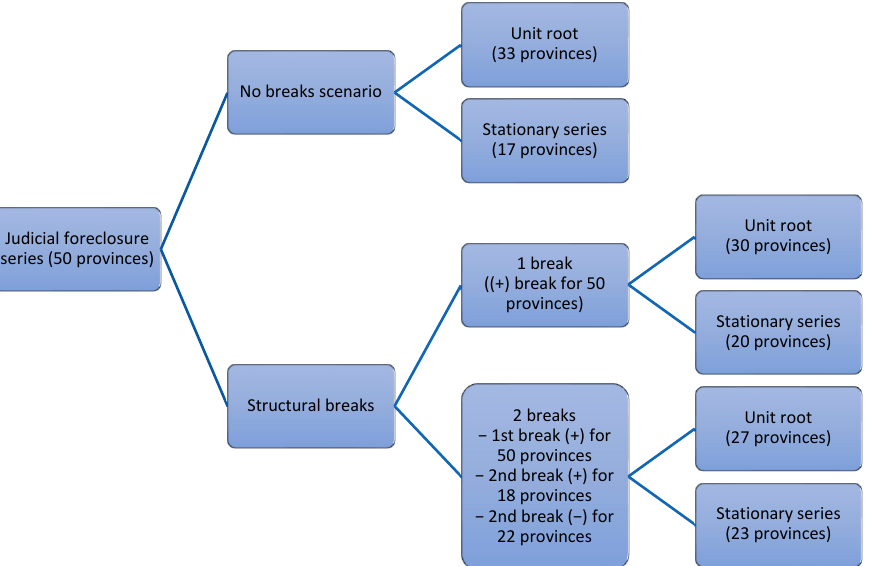
Figure 4. Summary of the main results at the 5% significance level.